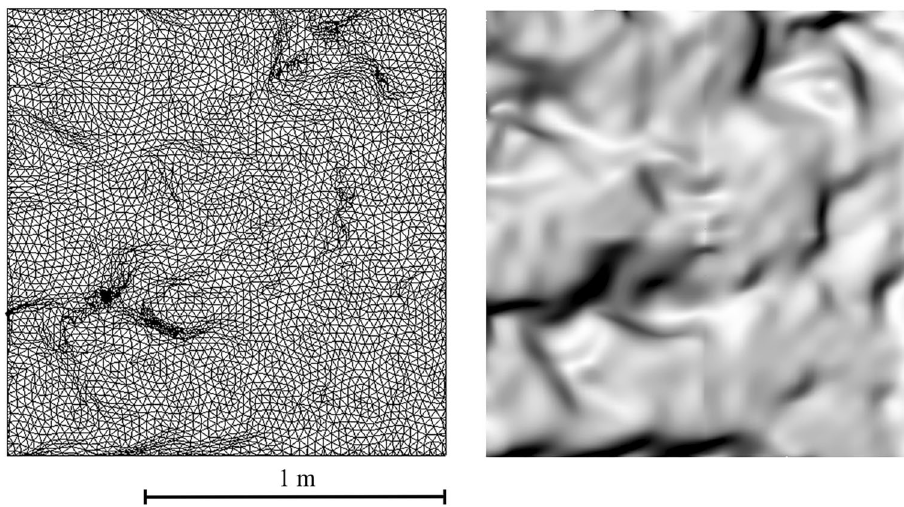
Fig. 11 A part of the AGH MS mesh network (left) and the NURBS surface patch (right)